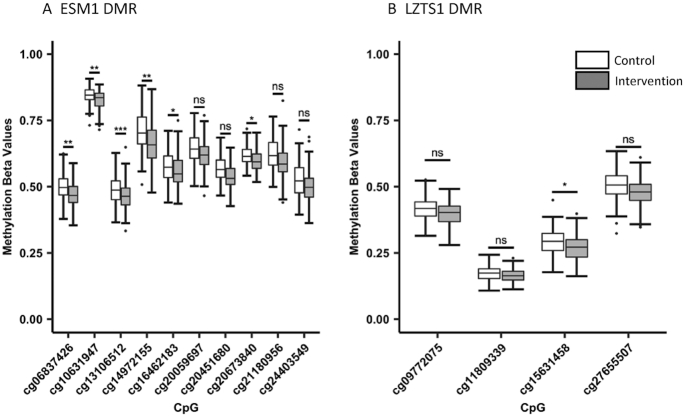
Boxplots showing the distributions of methylation values for the CpGs within the (A) ESM1 and (B) LZTS1 DMRs identified in the Gambian epigenome-wide association study regional analysis (n = 289). DMRs were identified using DMRcate and comb-p methods. In ESM1, 4 CpGs are also significant differentially methylated positions (DMPs) [false discovery rate (FDR) < 5%]. LZTS1 contains no significant DMPs. In both regions, the intervention is consistently associated with reduced methylation concentrations. Blank and filled boxes represent control and intervention arms, respectively. CpG site-wise false discovery rates: *FDR < 0.1; **FDR < 1×10-2; ***FDR < 1×10-3. DMR, differentially methylated regions; ns, not significant.